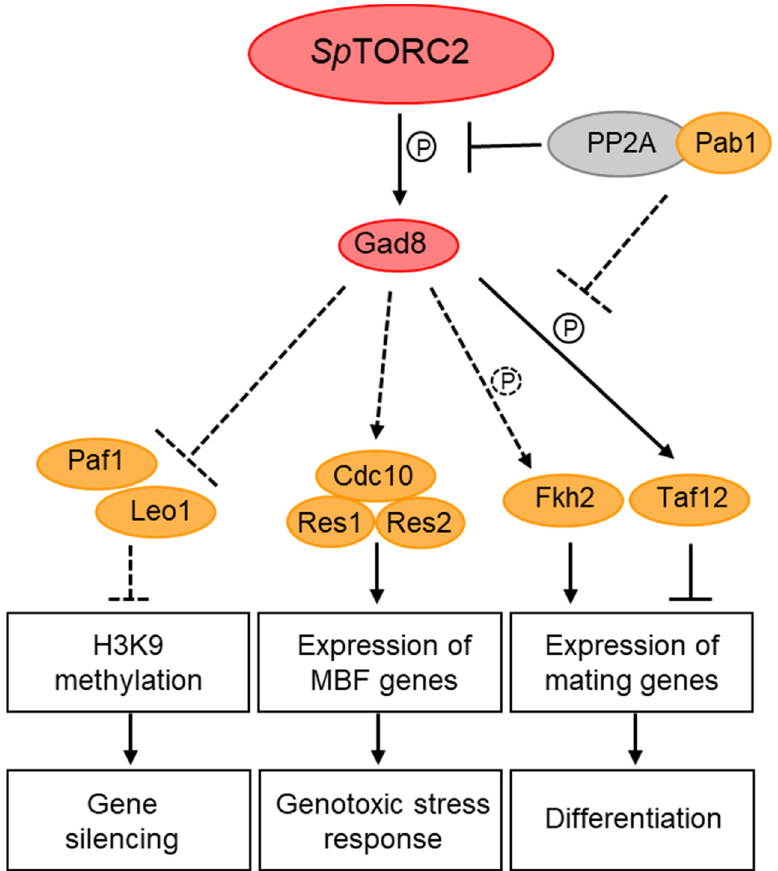
Figure 4. Role of the Sp TORC2 complex in transcriptional and epigenetic regulation. Dashed arrows indicate regulation that is either indirect, or not yet known to be direct. Solid lines indicate direct regulation. P denotes phosphorylation. The P circled with a dashed line indicates uncertainty about in vivo phosphorylation. Yellow circles indicate proteins that physically interact with Gad8. Notably, Paf1, Leo1, Taf12, and Pab1 are found primarily in the nucleus.